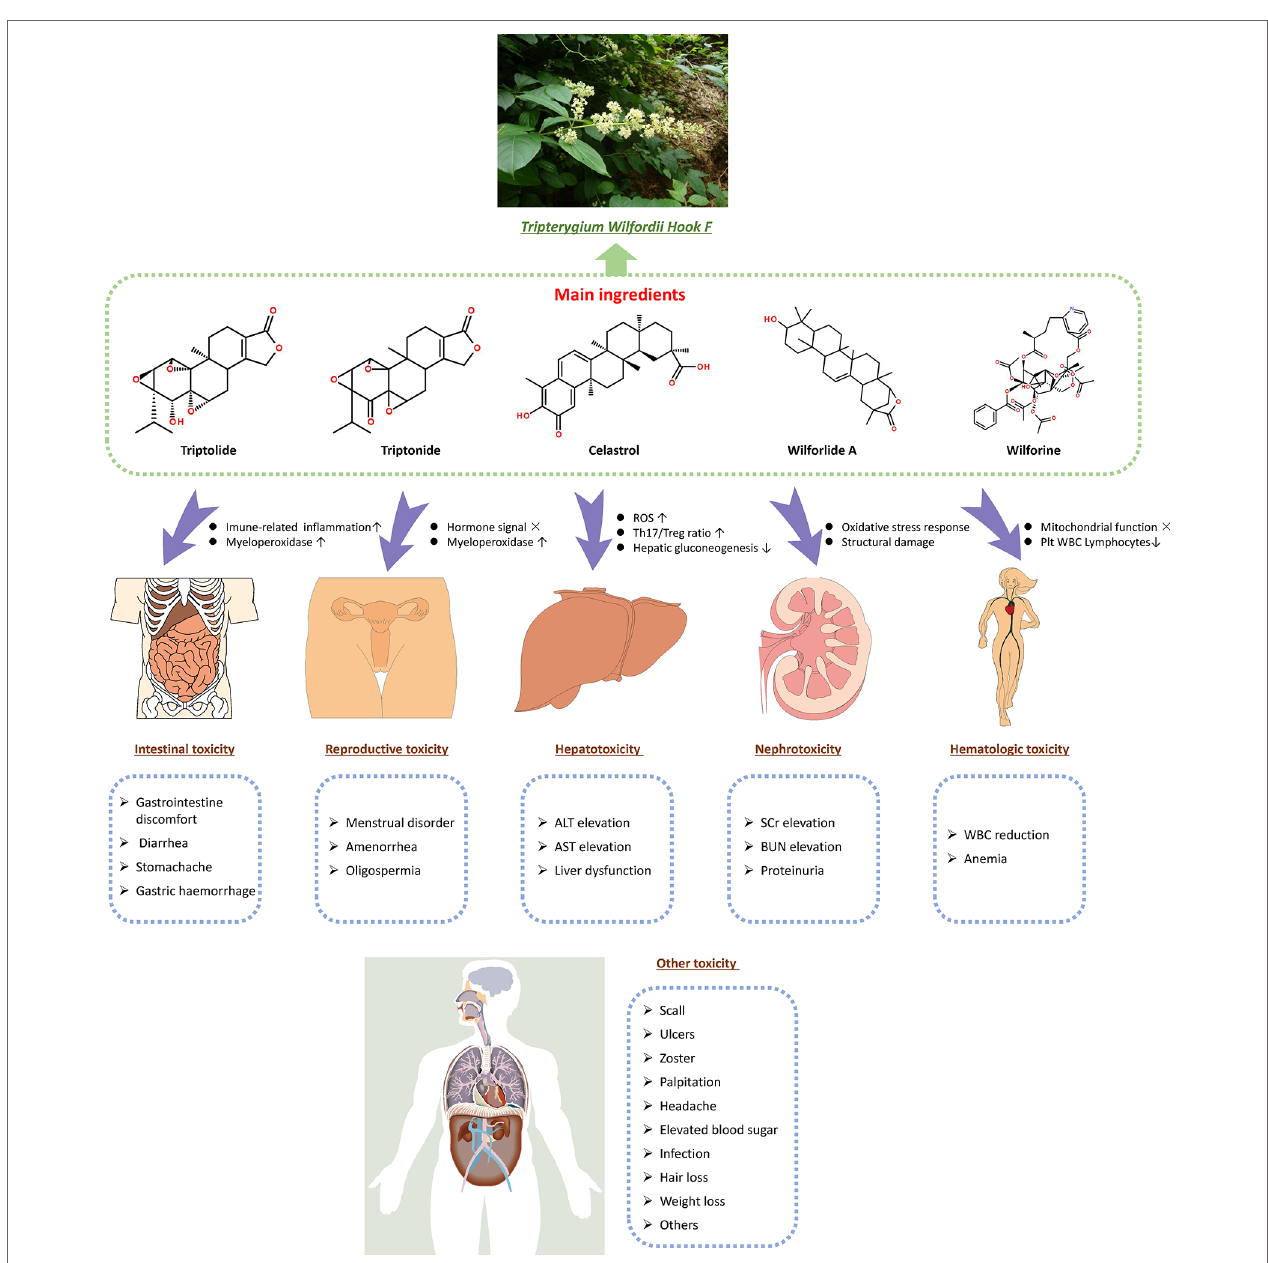
FIGURE 5 | Effective constituents of TwHF (such as triptolide, triptonide, celastrol, and wilforine) are both the active ingredients and toxicity source. TwHF induces toxicity in various target organs. In the digestive system, TwHF causes gastric mucosa irritation and increases the infiltration of inflammatory cells in the gastrointestinal tract. TwHF also disrupts the signaling of sex hormones and myeloperoxidase in reproductive organs, causes oxidative stress, increases the ratio of Th17/ Treg, and suppresses hepatic gluconeogenesis. In the kidneys, TwHF decreases the activities of renal SOD and GSH and increases the level of MDA and BUN, resulting in serious oxidative stress and structural damage. TwHF can affect mitochondrial function and reduce the number of platelets, WBC, and lymphocytes. TwHF, Tripterygium wilfordii Hook F; ROS, reactive oxygen species; Plt, blood platelet; WBC, white blood cell; ALT, alanine aminotransferase; AST, aspartate aminotransferase; SCr, serum creatinine; BUN, blood urea nitrogen; SOD, superoxide dismutase; GSH, glutathione; MDA, malondialdehyde; WBC, white blood